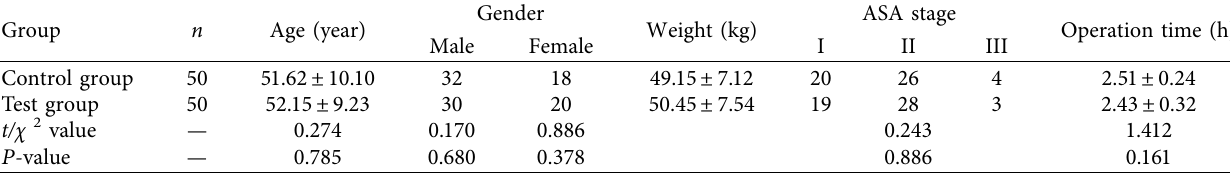
Table 1: Comparison of general information of patients (n (%), x ± s ).